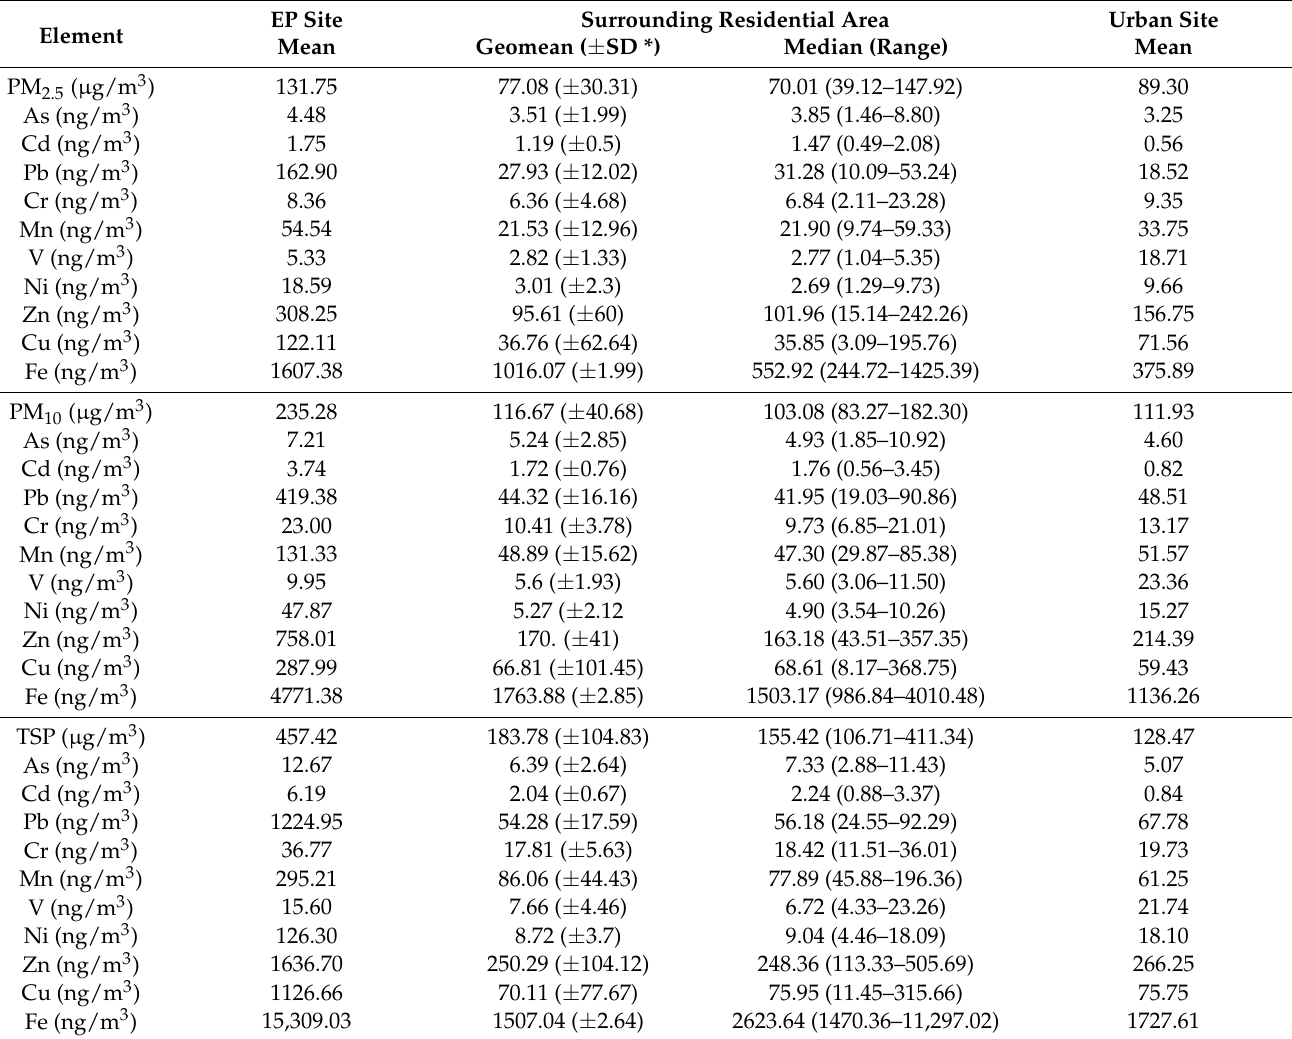
Table 1. Mass concentrations of PM 2.5 , PM 10 , and TSP, and relevant metal